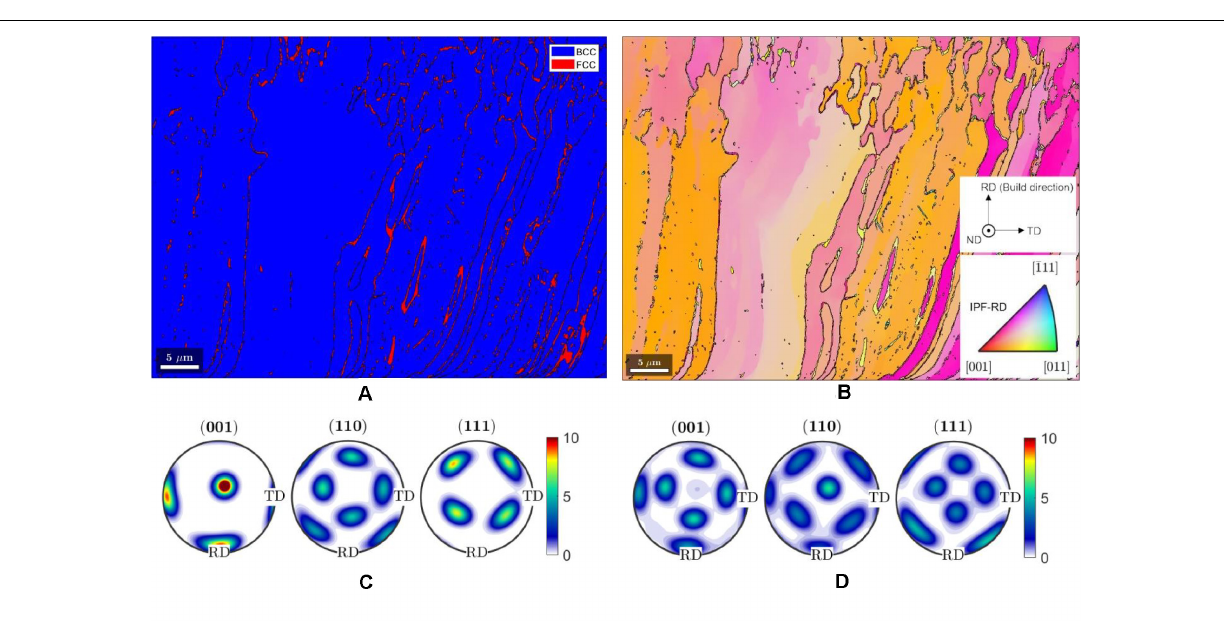
Frontiers in Materials |